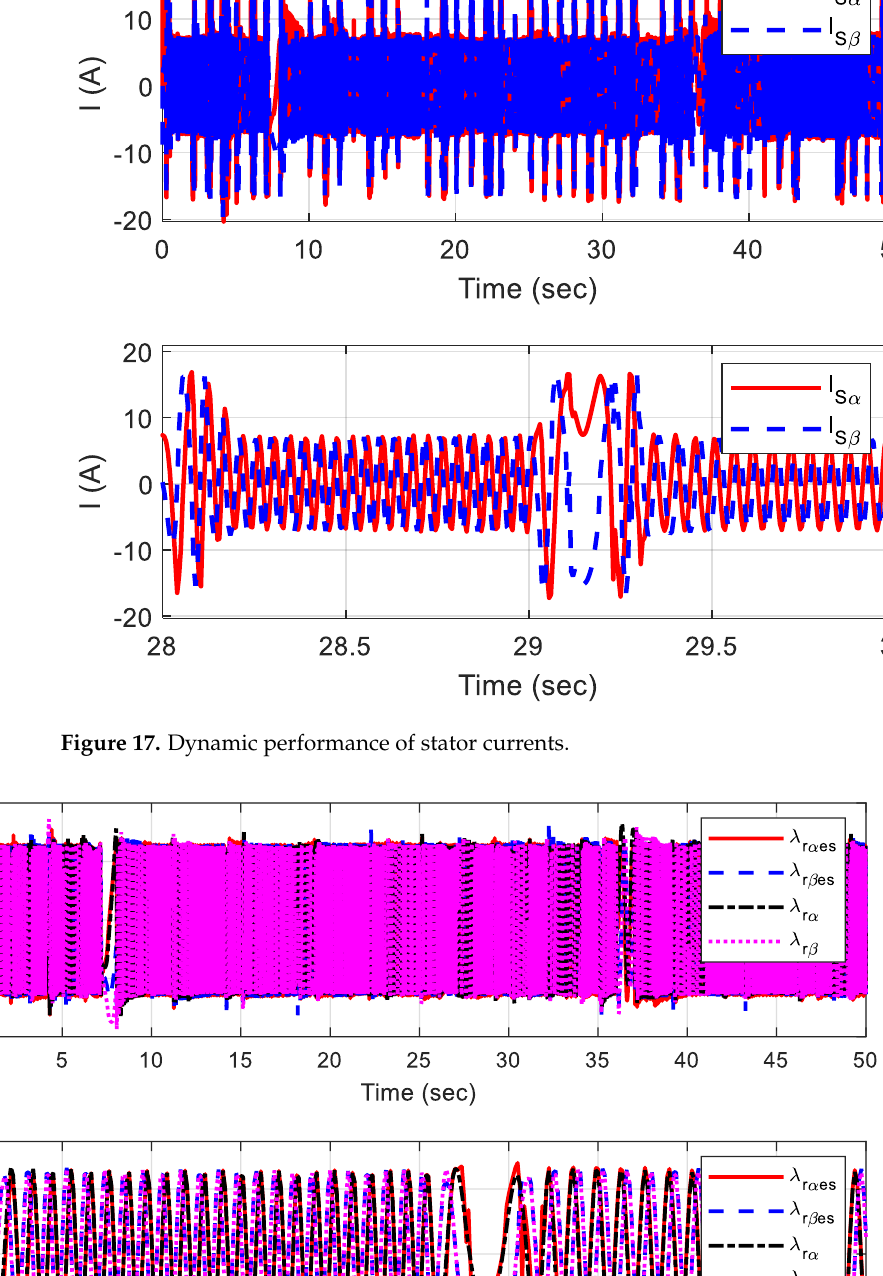
Figure 16. Dynamic performance of load and electromagnetic torques.